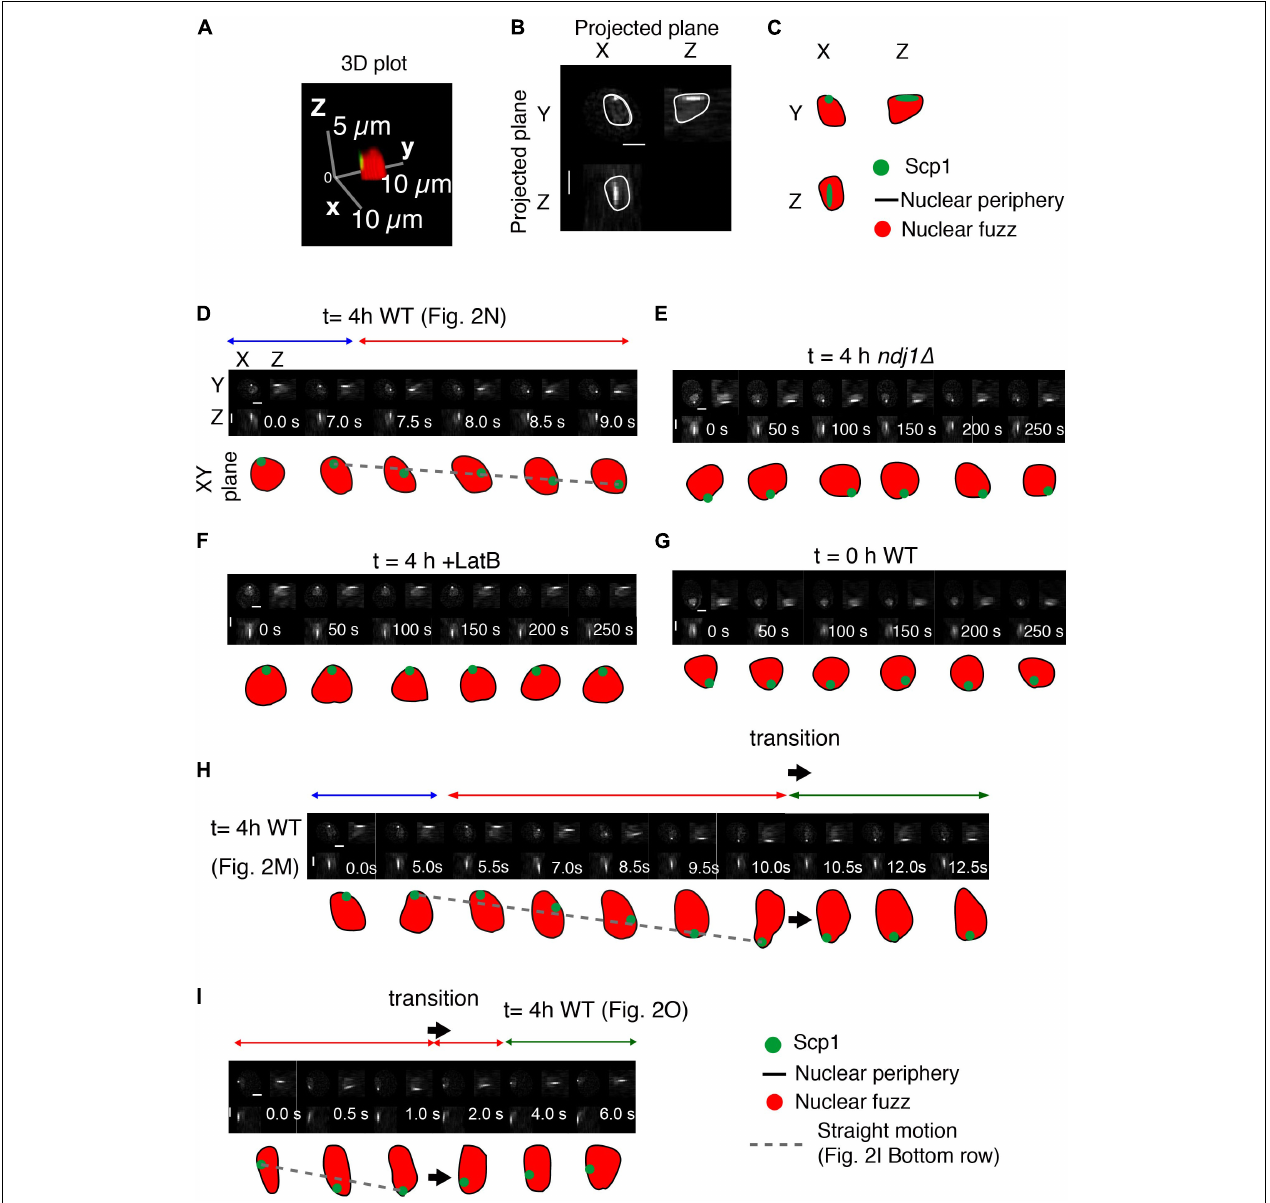
FIGURE 3 | Interplay between telomeres and nuclear envelope. (A–C) Analysis of a representative nucleus showing the definition of the nucleus, based on the nuclear fuzz (red) that is derived from the unbound TetR-mEGFP in the nucleus, and thus the nuclear periphery (NP; black line) plus the position of the spot corresponding to scp1::tetO -TetR-mEGFP. (A) 3D representation. (B) Projections onto the XY, XZ, and YZ planes. (C) Interpretation. (D–I) Projected images of the nuclear region and tagged SCP1 locus with the nature of spot motion (above; horizontal arrows). Sequences in (D,H,I) are from the trajectories shown in Figures 2M–O , respectively. Scale bar is 2 µ